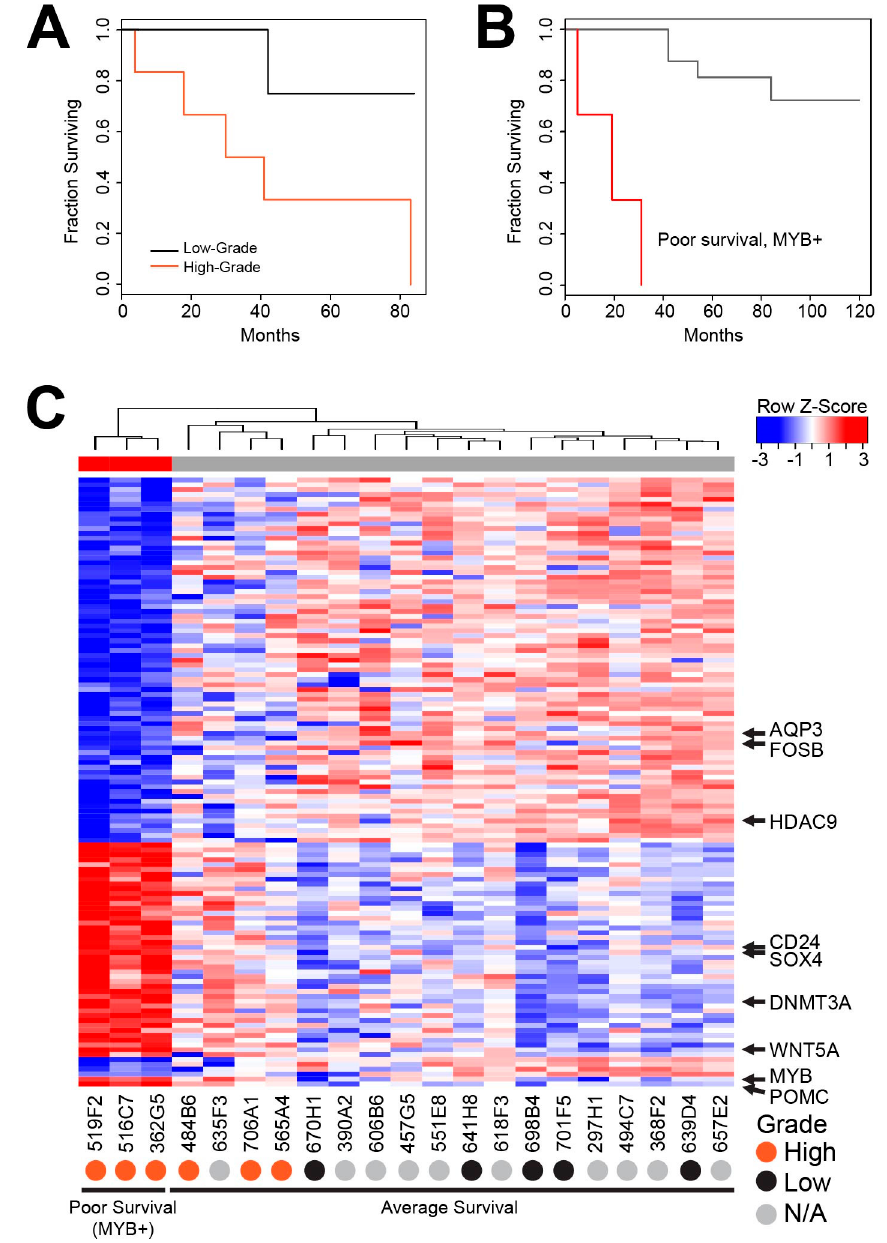
Figure 3. Poor survival subgroup of AcCC Tumors. ( A ) Kaplan–Meier survival curve comparing the high-grade transformation samples (orange) to low-grade samples (black). Note: grade information was not available for some samples, they were excluded; ( B ) Kaplan–Meier survival curves comparing the MYB -expressing (red) group from Figure 2 with all other samples (gray); ( C ) heatmap summarizes the differences in gene expression between the poor survival subgroup (left, red color bar) and the rest of the samples (gray color bar). Positions of some noteworthy genes are marked. Full-sized heatmap with all the genes labeled is provided in Figure S3.